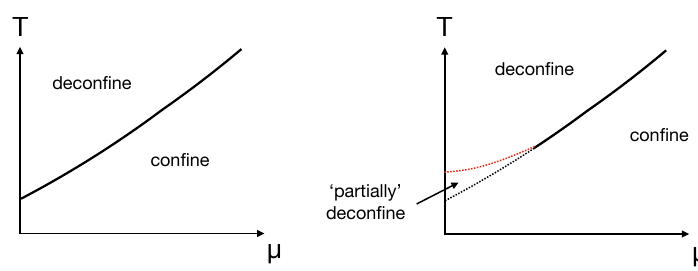
Figure 9. Possible phase diagrams of the bosonic BMN model for the canonical ensemble. Ref. [64] concluded that the left figure is the actual phase diagram.